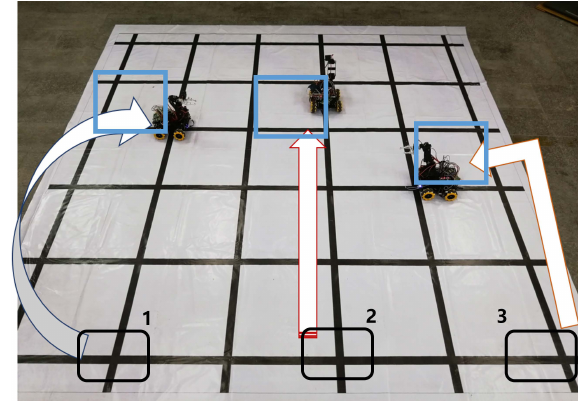
Figure 11. The actual test